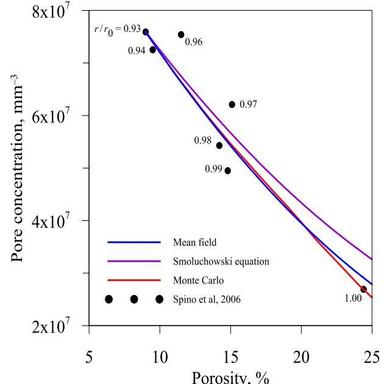
Comparison of deterministic (Smoluchowski equation) and stochastic (Monte Carlo) calculations of densityporosity correlation under conditions of experiment.